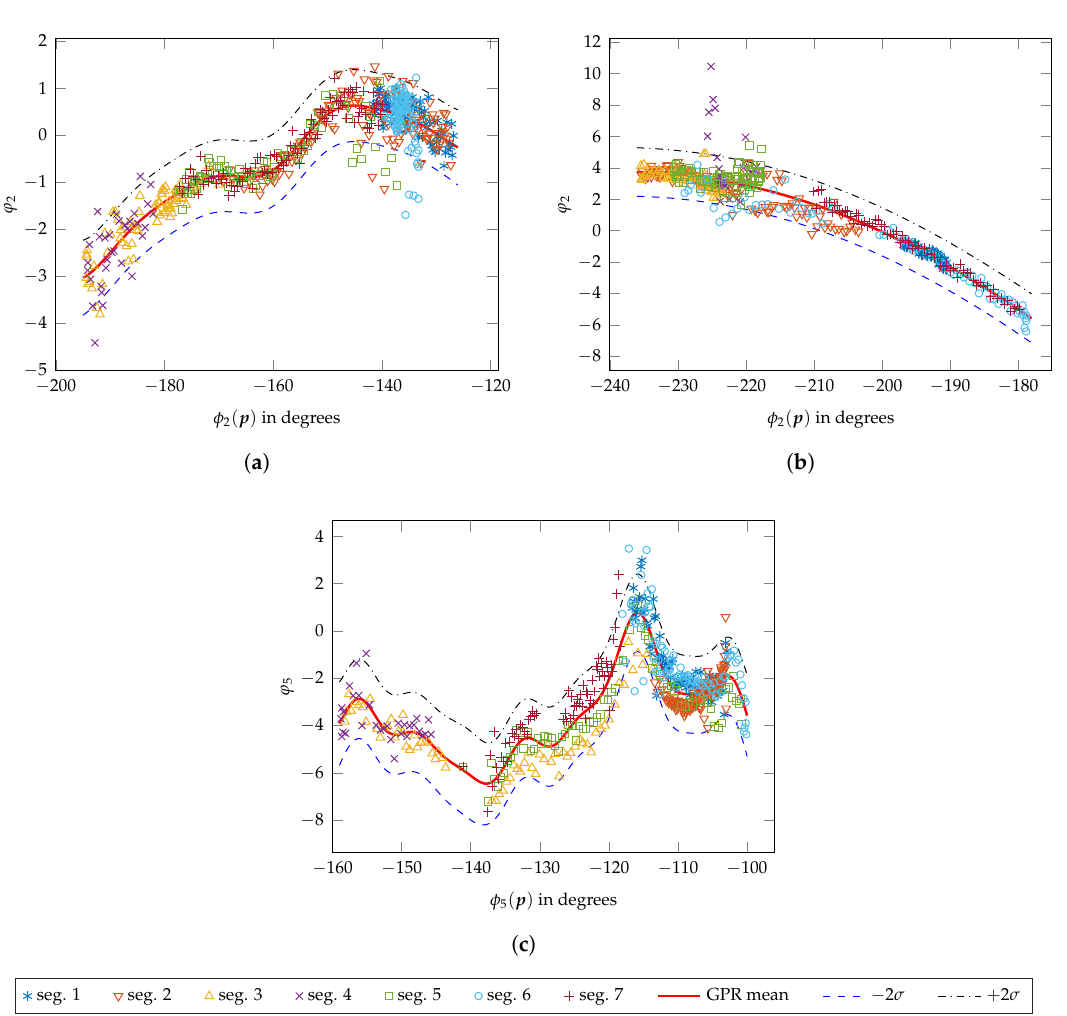
associated with 2 associated with anchor 2 2 associated with anchor 1 (north glass 5